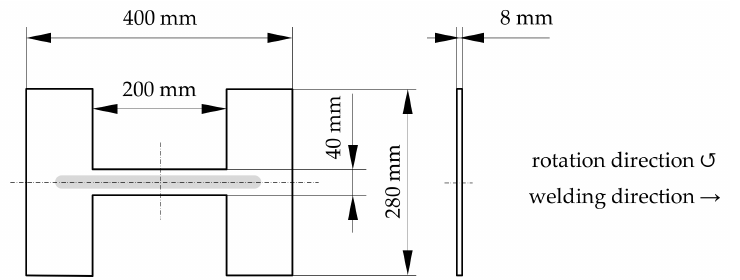
Figure A3. Geometry for experiment no. 14, data from [7], the narrowed zone causes heat accumulation. The welds are indicated in grey.